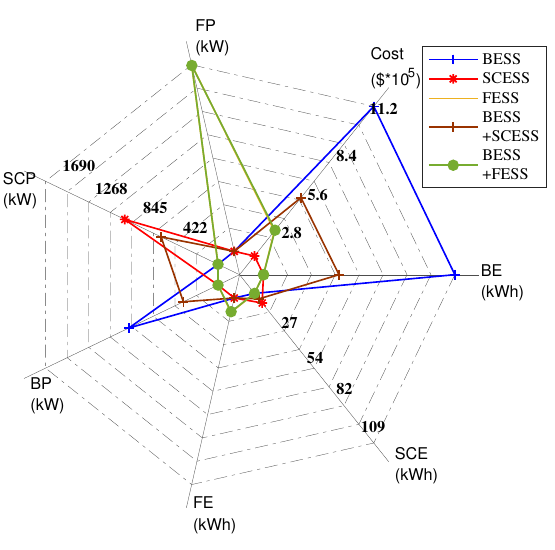
Figure 9. Comparison of different combinations of ESS for 25% regenerative energy saving, where BE: Battery Energy, BP: Battery Power, SCE: SC Energy, SCP: SC Power, FE: Flywheel Energy, FP: Flywheel Power. The axes for energy are scaled from 0–109 kWh, those for power are scaled from 0–1690 kW, and the axis for cost is scaled from $0.93 × 10 5 –11.2 × 10 5 .